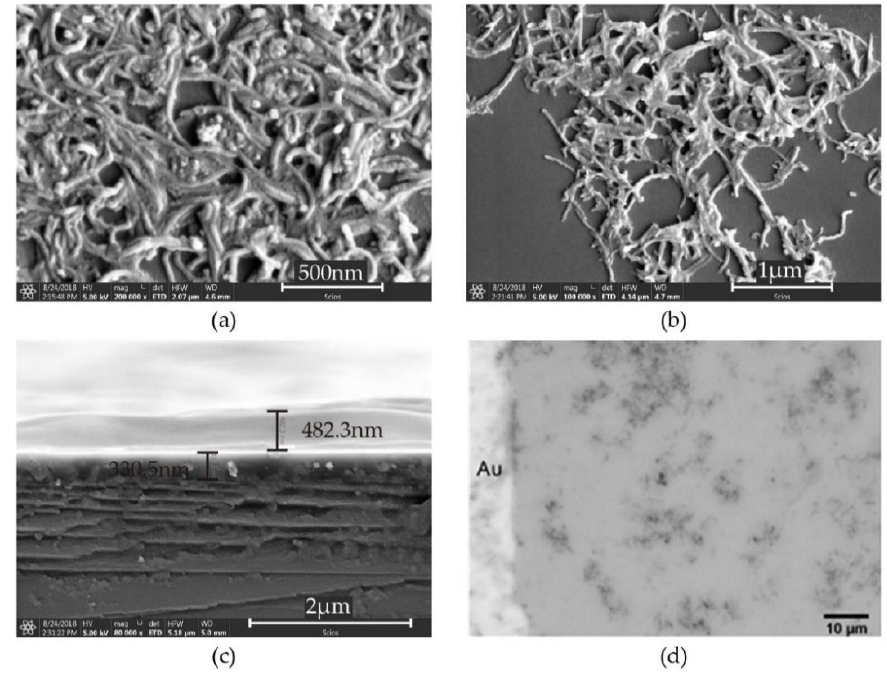
Figure 4. FESEM images of ( a ) MWCNTs on silicon dioxide; ( b ) PEG/MWCNTs on silicon dioxide; ( c ) the cross section of MWCNTs and PEG composite layer. ( d ) Optical microscope images of MWCNTs and PEG composite layer.